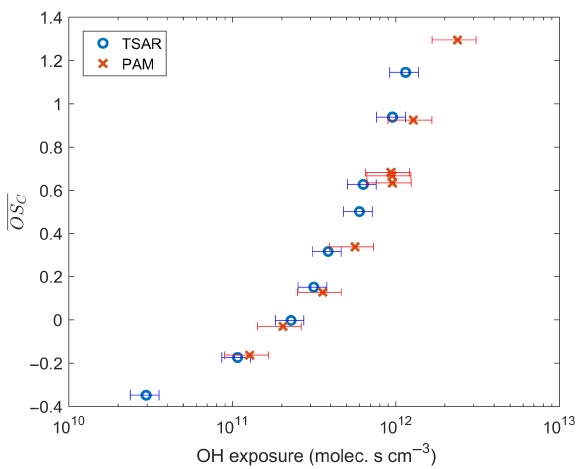
Figure 12. The average carbon oxidation state (OS C ) as a function of OH exposure for PAM- and TSAR-generated toluene